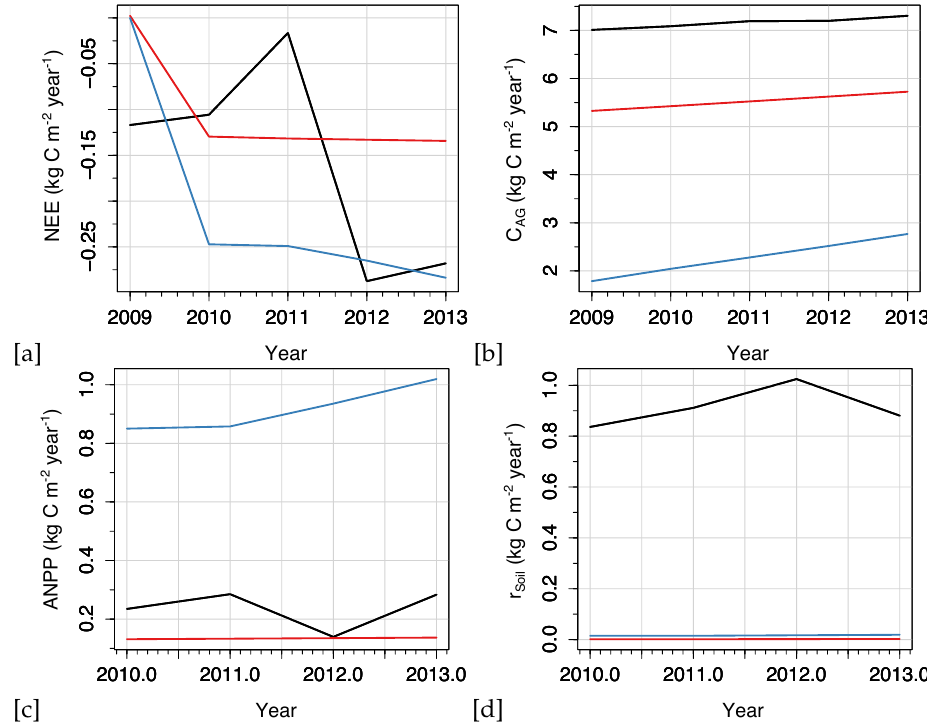
Figure 8. Simulated and observed NEE, C AG , ANPP, and r Soil for the JERC-RD site; black = observations; red = PPA-SiBGC; blue = LANDIS-II NECN; ( a ) = NEE; ( b ) = C AG ; ( c ) = ANPP; ( d ) = r Soil .